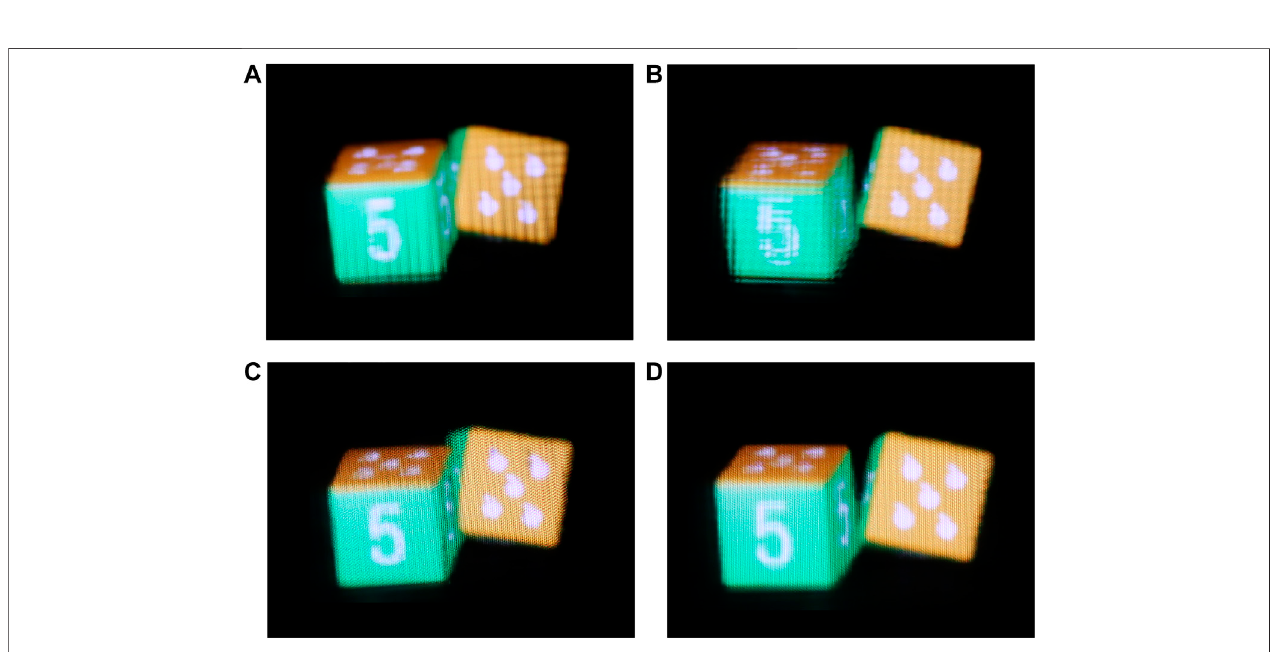
FIGURE10| Acomparison ofopticalreconstructionresultsforvirtual capturescenes.SPOC: (A) left7 ° viewingangle and (B) right7 ° viewingangle.Theproposed method: (C) left 7 ° viewing angle and (D) right 7 ° viewing angle.